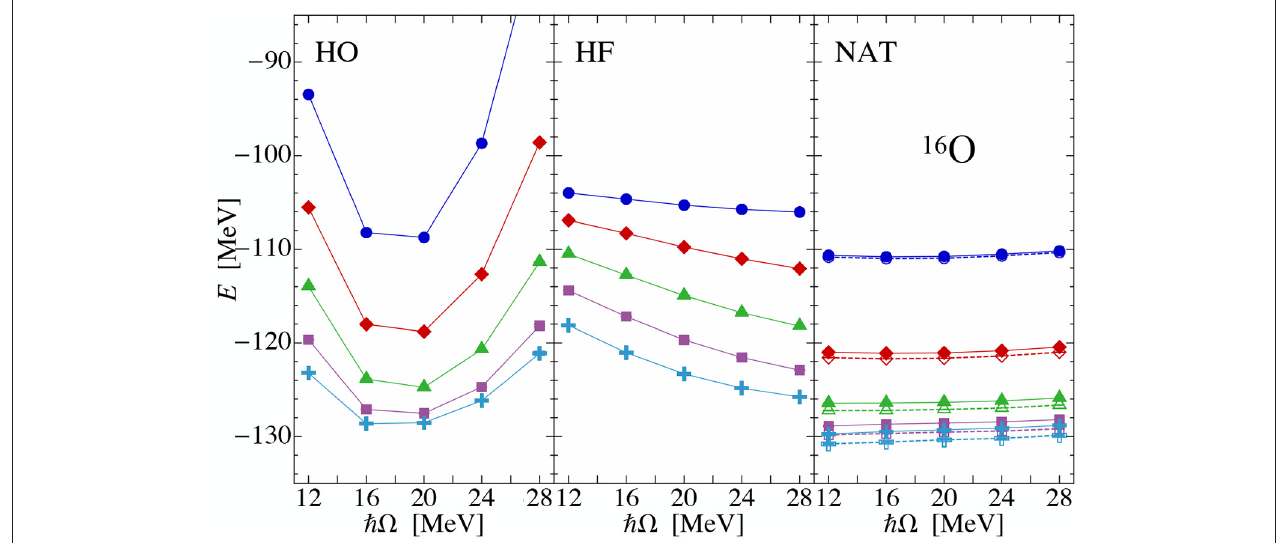
FIGURE 12 | NCSM ground-state energy of 16 O as a function of the frequency ¯ h ω (denoted as ¯ h (cid:127) on the figure) of the underling HO basis for N max = 2,4,6,8,10 spaces. The NCSM diagonalization itself is performed either in the initial HO basis (left) , in the HF basis (center) , or in the natural-orbital basis from second-order HF-MBPT (right) . The Hamiltonian described in section 3 is employed. Reproduced from Tichai et al. [ 113] with permission from the American Physical Society.